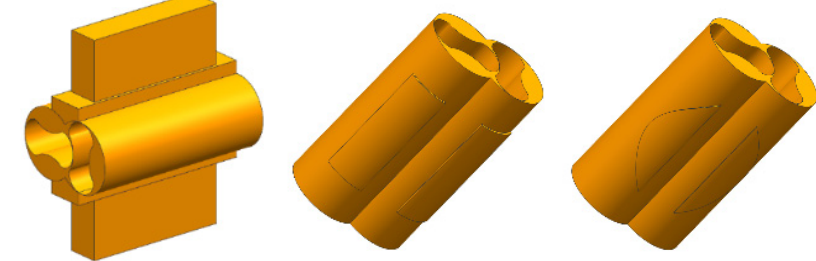
Figure 3. The fluid domain.